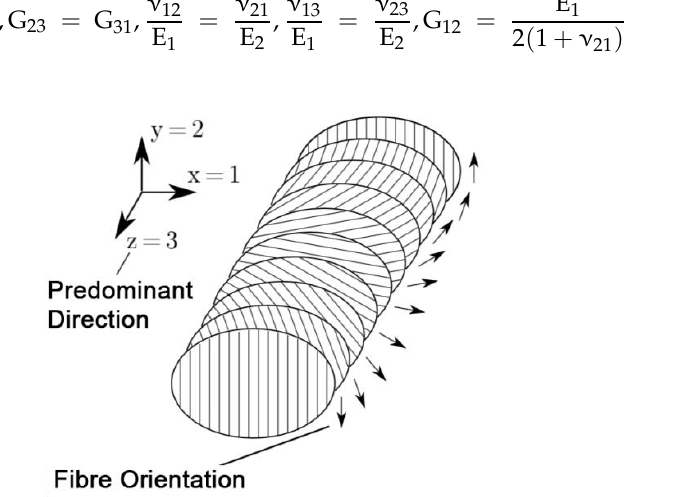
Figure 8. Transversal isotropic material architecture under consideration of Bouligand helix model of spatial orientation of the chitin fibres in the procuticle.